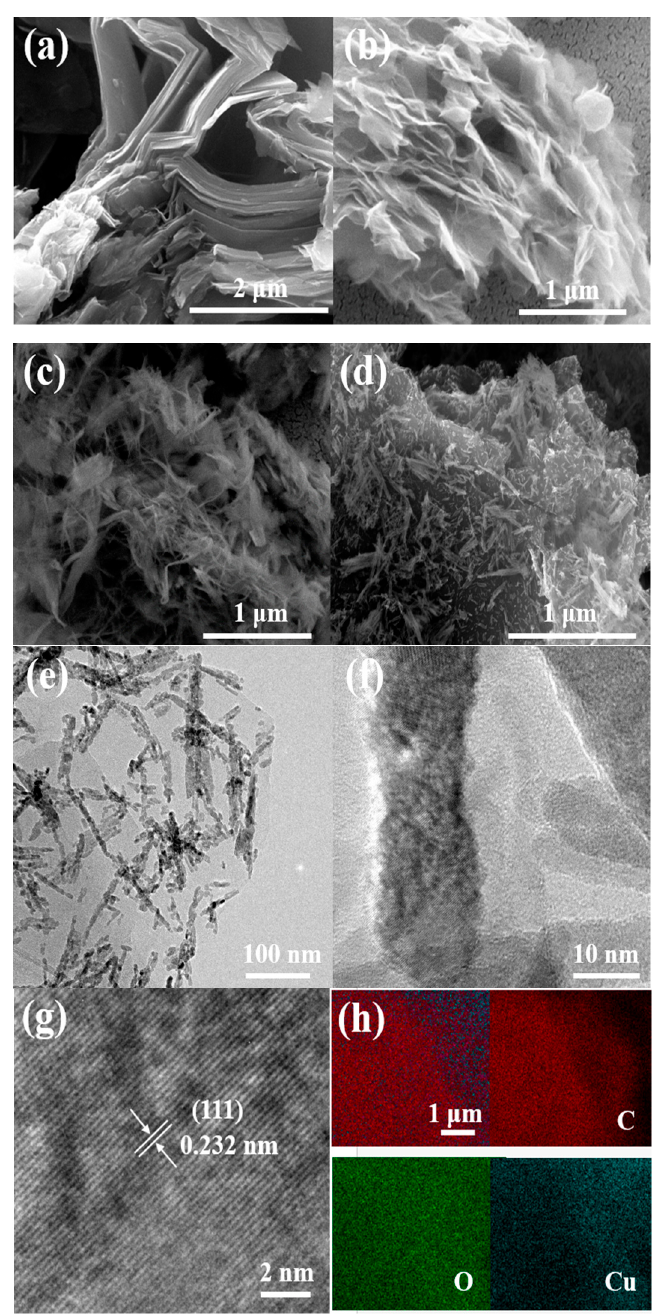
Figure 2. SEM images of ( a ) raw graphite; ( b ) the f-graphene; ( c ) pure CuO NWs; ( d ) the CuO/f-graphene composite; ( e ) TEM image of the CuO/f-graphene composite; ( f , g ) HRTEM images of the CuO/f-graphene composite; and ( h ) SEM elemental mapping of the CuO/f-graphene composite.